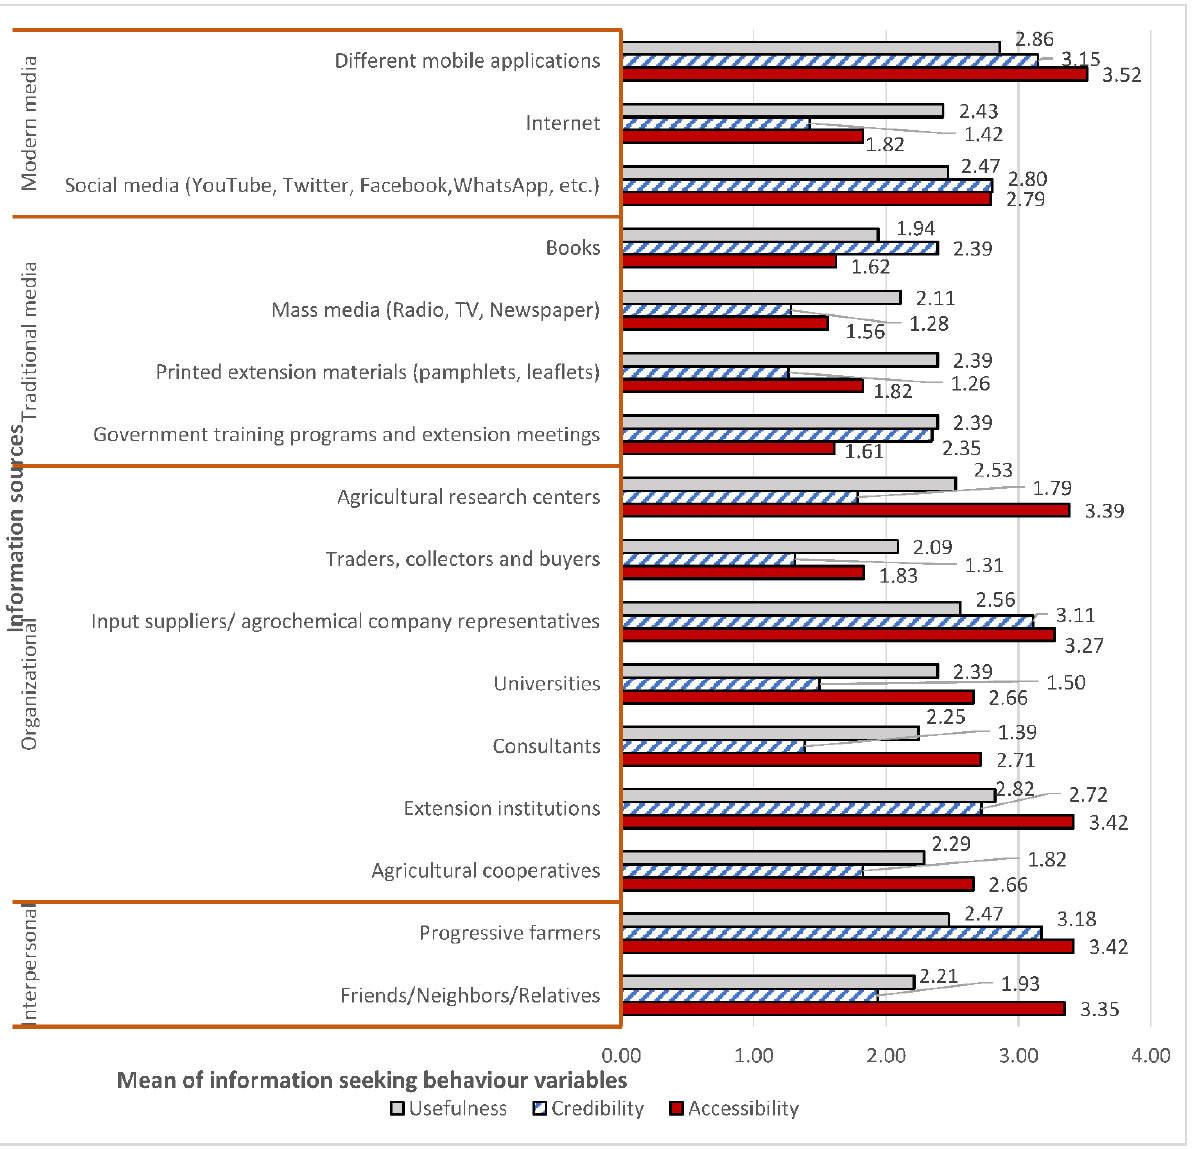
Figure 3. Farmers’ information-seeking behavior with various information sources.